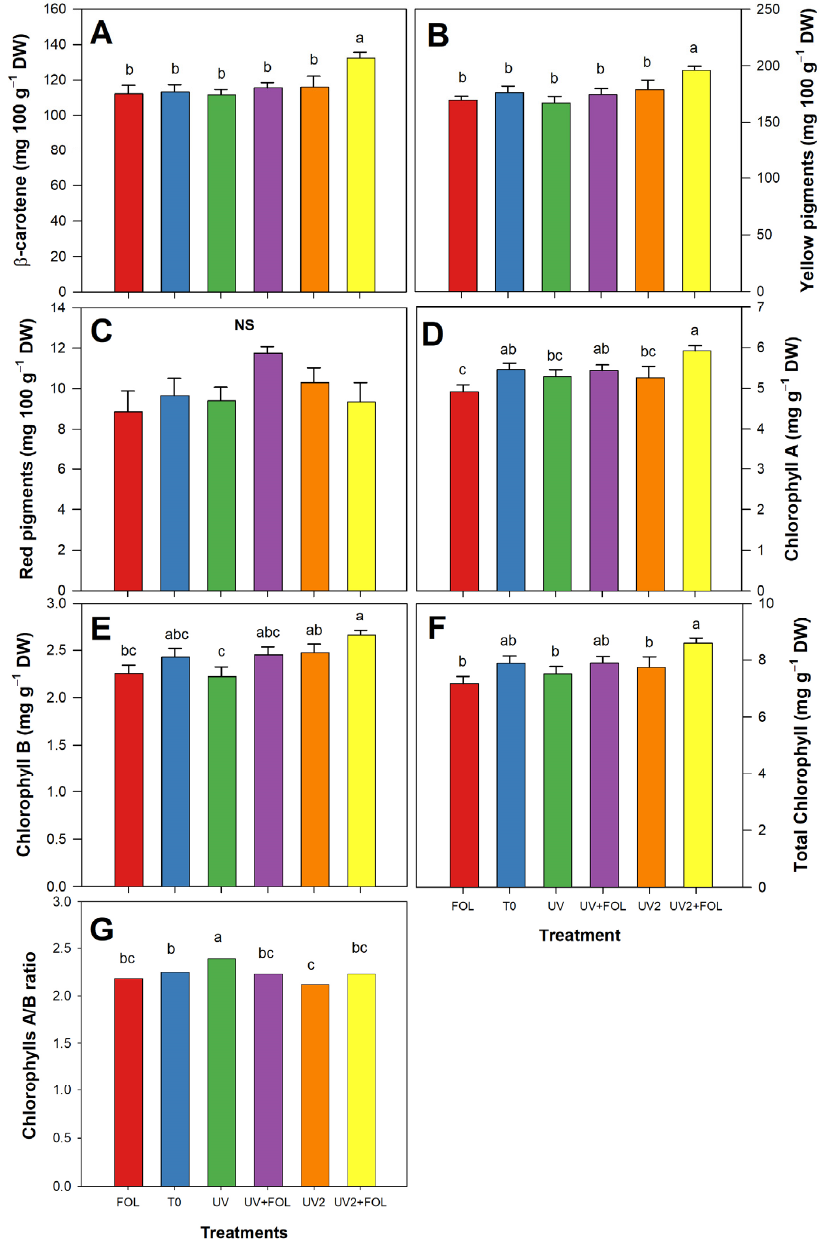
Figure 6. Photosynthetic pigment contents in leaves of tomato plants inoculated with Fol and supplemented with UV-A radiation. ( A ) β -carotene, ( B ) Yellow pigments, ( C ) Red pigments, ( D ) Chlorophyll ( A , E ) Chlorophyll ( B , F ) Total Chlorophyll, and ( G ) Chlorophylls A/B ratio. The leaf samples (fully expanded young leaves) were collected 17 weeks after transplanting. Di ff erent le tt ers between treatments indicate signi fi cant di ff erences according to Fisher´s Least Signi fi cant Di ff erence test ( p < 0.05). n = 6 ± standard error. T0, negative control (tomato plants without UV-A radiation and without Fol inoculation); FOL, positive control (tomato plants only inoculated with Fol); UV, tomato plants supplemented with UV-A radiation through one LED lamp; UV + FOL, tomato plants supplemented with UV-A radiation through one LED lamp and inoculated with Fol; UV2, tomato plants supplemented with UV-A radiation through one LED lamp above the plant canopy plus one fi xed lamp at the bo tt om of the plants; and UV2 + FOL, tomato plants inoculated with Fol and supplemented with UV-A radiation through one LED lamp above the plant canopy plus one fi xed lamp at the bo tt om of the plants.